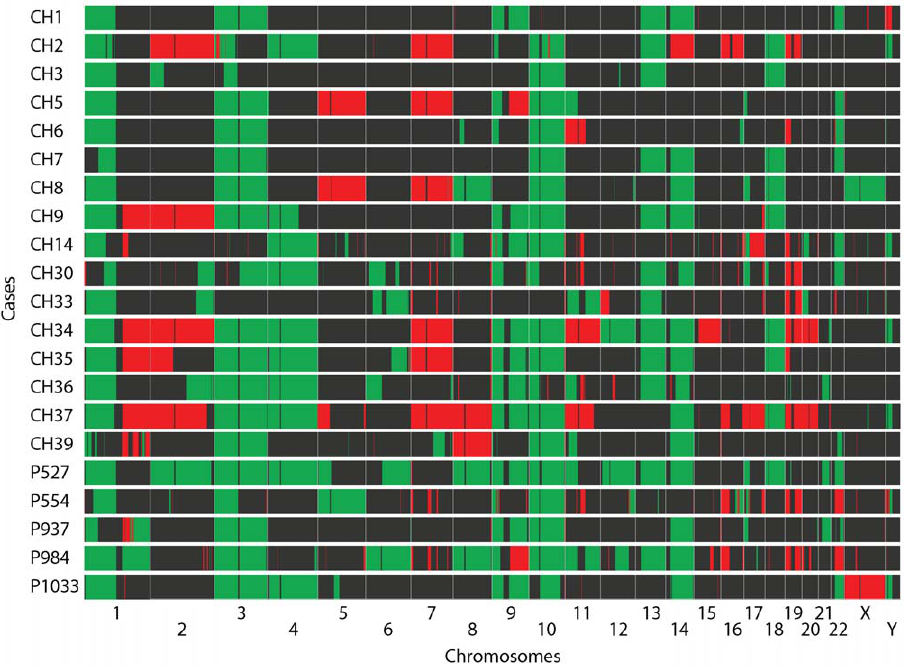
Figure 1. Heat map of array CGH results. Copy number gains (red) and losses (green) are displayed for each individual chordoma case (rows) with chromosomes organized in columns (separated by white vertical lines) and indicated by labels at the bottom. Note that cases CH34 and CH37 are recurrent tumors from the same patient. doi:10.1371/journal.pone.0018846.g001 PLoS ONE |